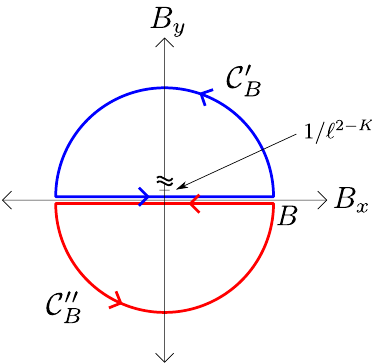
Figure 3: The “half-moon”-shaped contours C (cid:48) plane. The magnetic field in the semicircle portion is in the tight-binding regime Ba (cid:29) ( a /(cid:96) ) 2 − K . The Berry phase for either one of these paths is equal (up to expo- nentially small corrections) to the known Berry phase for a single braid of fractional quasiparticles.